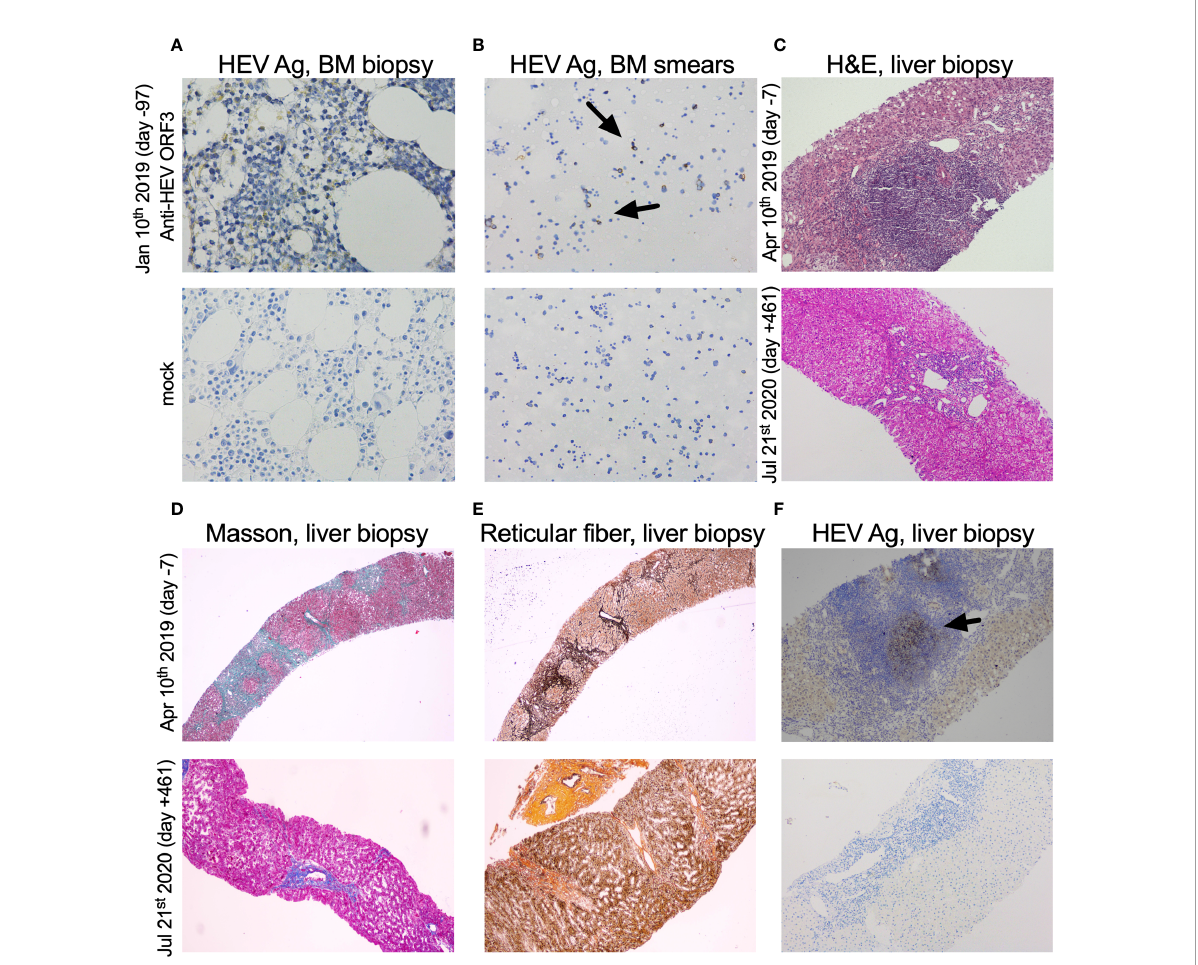
FIGURE 3 Immunohistochemical detection of HEV antigen and pathological analysis of bone marrow and liver biopsy samples. (A, B) HEV antigen (HEV Ag) detection of bone marrow (BM) biopsy (×400) and smears (×200). BM biopsy and smears (Jan 10 th 2019, day -97) collected from the case were shown. (C) H&E of the liver biopsy (×100). (D, E) Masson trichrome and reticular fi ber staining of liver biopsy (×40). (F) HEV Ag detection of liver biopsy (×100). Liver biopsy samples prior to and after oral ribavirin (Apr 17 th 2019, day 0) were shown above (Apr 10 th 2019, day -7) and below (Jul 21 st 2020, day +461), respectively. The time of sample was designated on the left side of each row of pictures. HEV-speci fi c anti- ORF3 1E6 antibodies (Millipore, Temecula, CA) were used in IHC of HEV